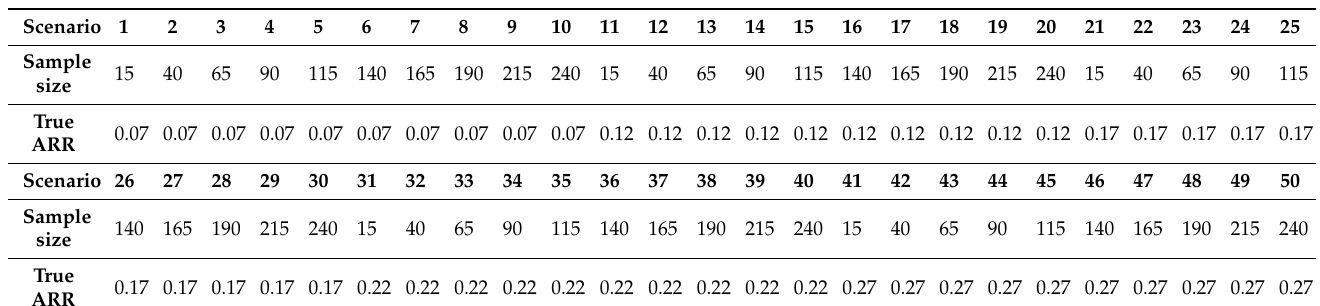
Table 1. Simulation